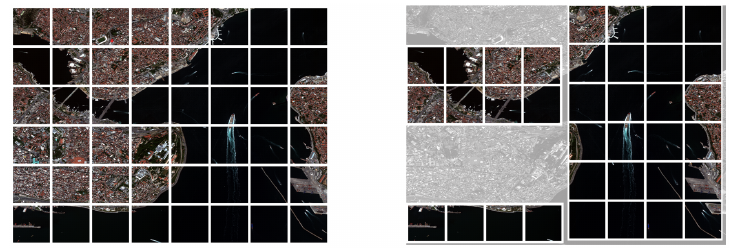
Figure 4. Comparison of uniform cropping ( left ) and the proposed clustering-guided cropping ( right ).